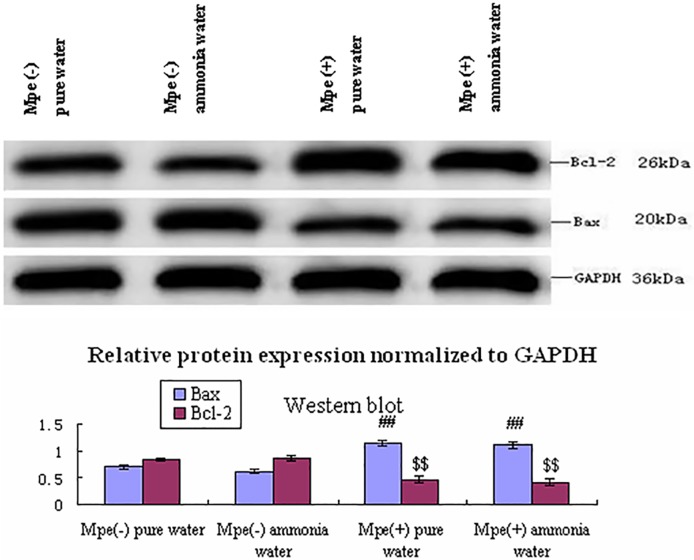
The Bax and Bcl-2 expression in different groups.Western blot analysis of Bax and Bcl-2 protein expression in gastric mucosa of Mpe infected and uninfected mice sub-groups, Data is representative of three independent experiments.(n = 3) (# <0.01, $ <0.01).